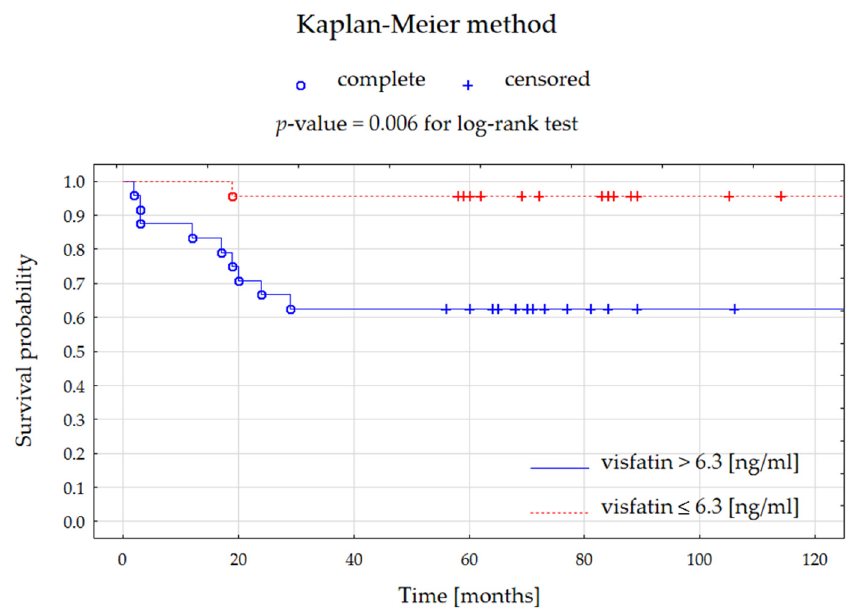
Figure 3. Kaplan-Meier curves presenting the survival probability for patients with all adrenocortical tumors depending on visfatin serum level for 10 years of follow-up.